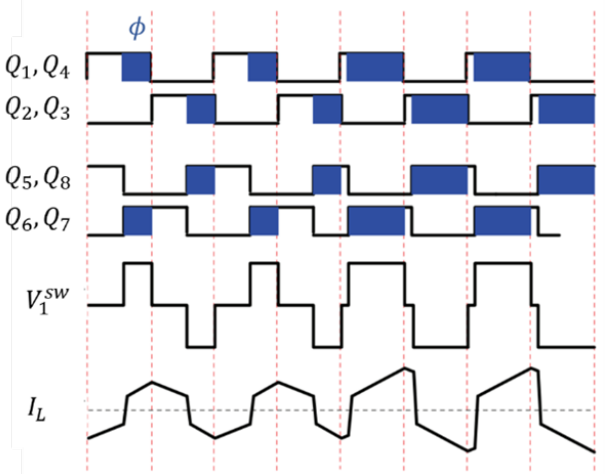
Figure 9. Effect of voltage phase shift φ variation on current I L .